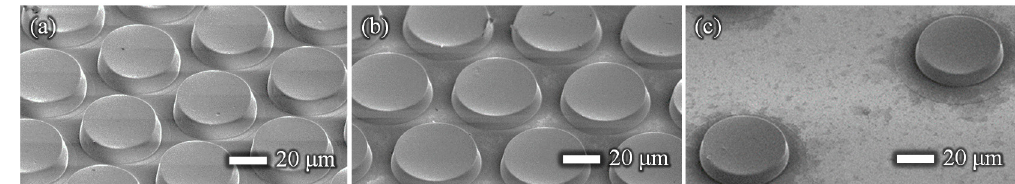
Figure 2. SEM images of the micropillar arrays on the base film. The diameter and height of the micro- pillars for all dimensions are 50 and 10 µm, respectively. The pillar gaps are ( a ) 5, ( b ) 10, and ( c ) 50 µm.